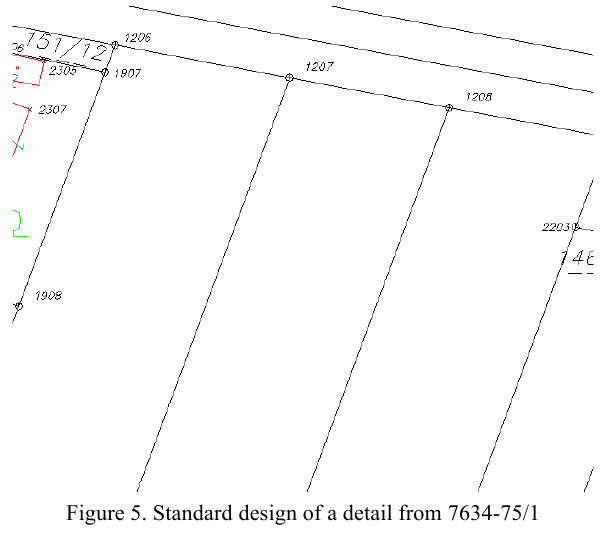
Figure 5. Standard design of a detail from 7634-75/1 (Leopoldseder, 2015, p. 35, data: © BEV)